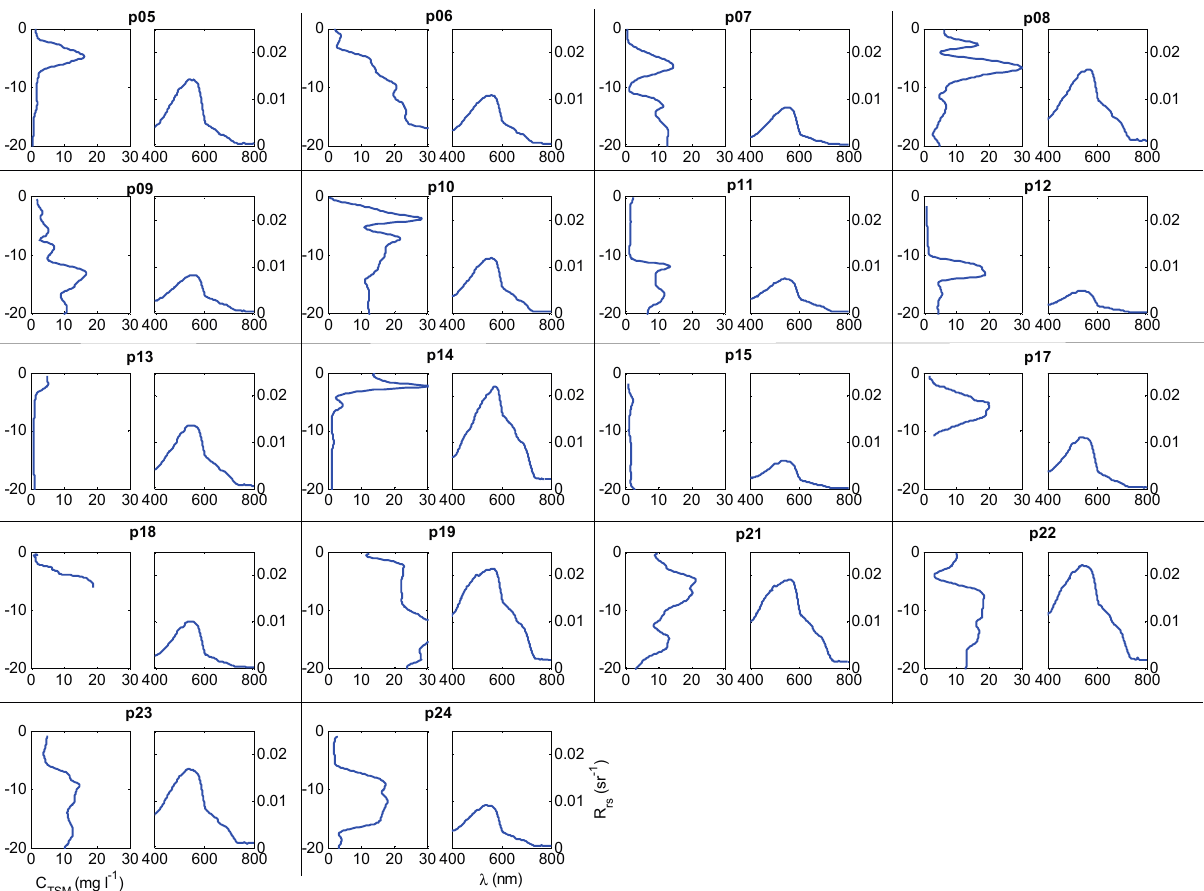
Figure 3. Attenuation-derived sm(z) ( left ) and R p05–p24. For legibility reasons, units are indicated only in two reference graphs at the bottom